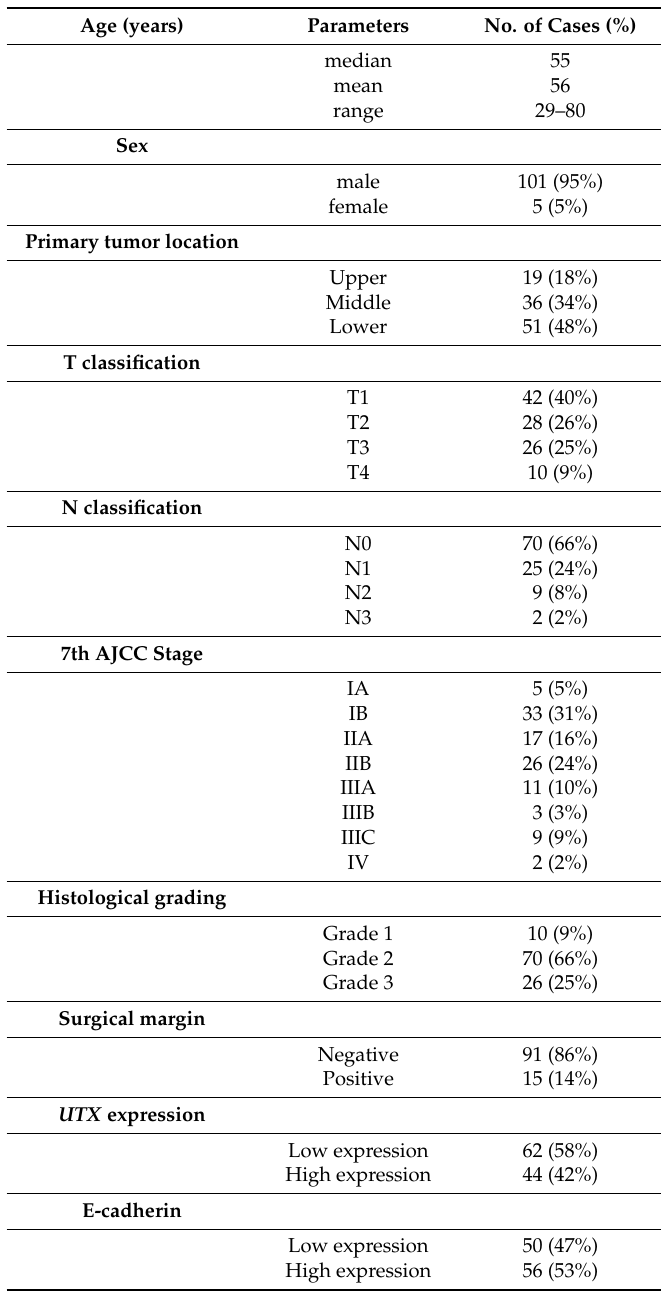
Characteristics of 106 patients with esophageal squamous cell carcinoma (ESCC) receiving